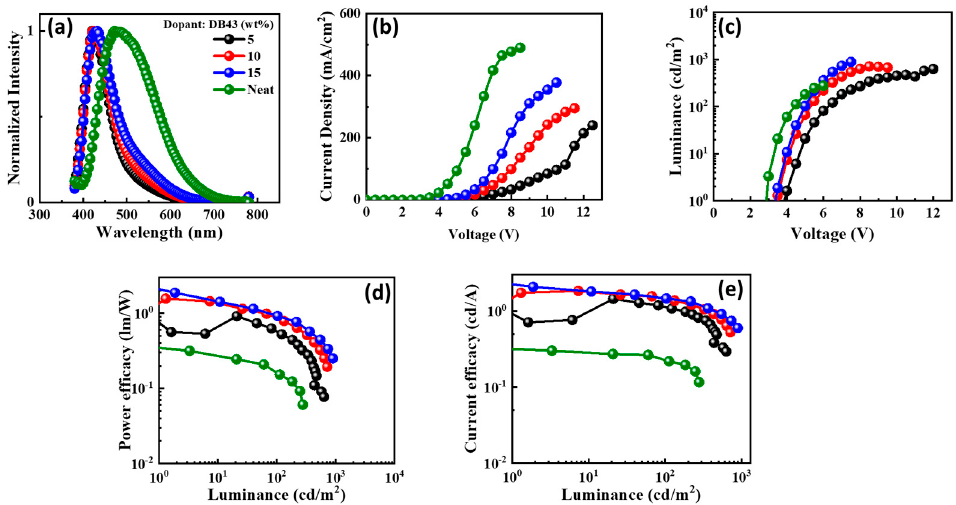
Figure 15. The electroluminescent (EL) properties of the device with emitter DB43 doped in CBP host matrix at varying concentrations showing ( a ) EL spectra, ( b ) current density–voltage, ( c ) luminance–voltage, ( d ) power e ffi cacy–luminance, and ( e ) current e ffi cacy–luminance characteristics.